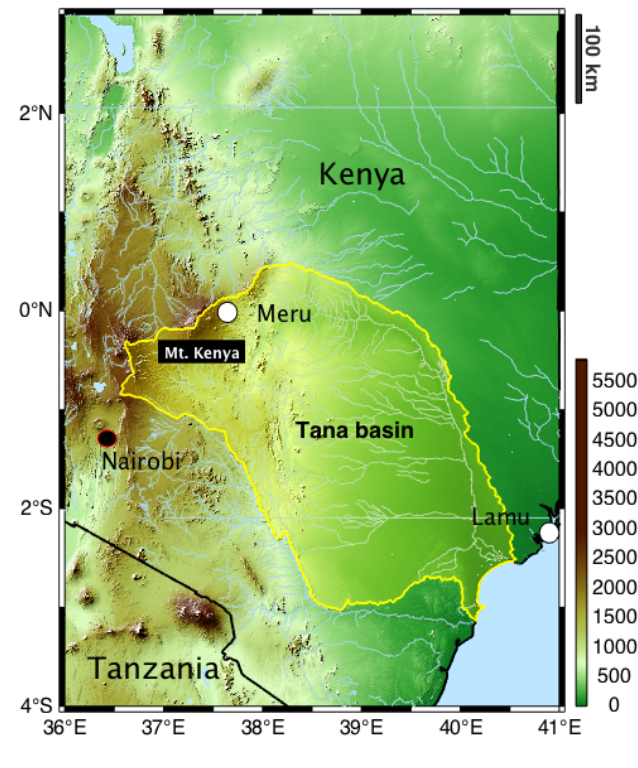
Figure 1. Location of Precipitation ( P ) and Temperature ( T ) measurement stations in